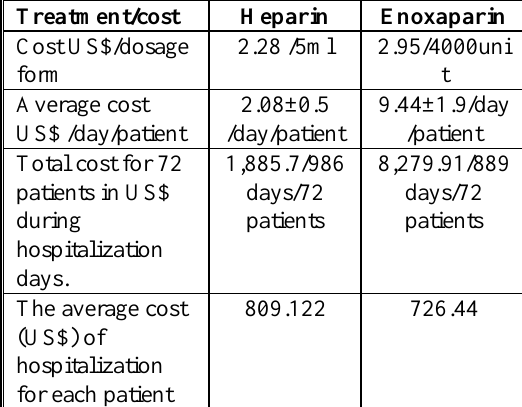
8. Costs of treatment with anticoagulants (Heparin and Enoxaparin) of hospitalized, severe infected